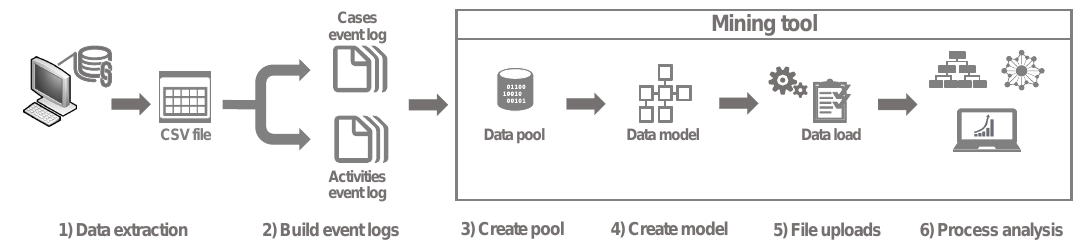
Figure 2. Steps followed for data processing and process analysis.